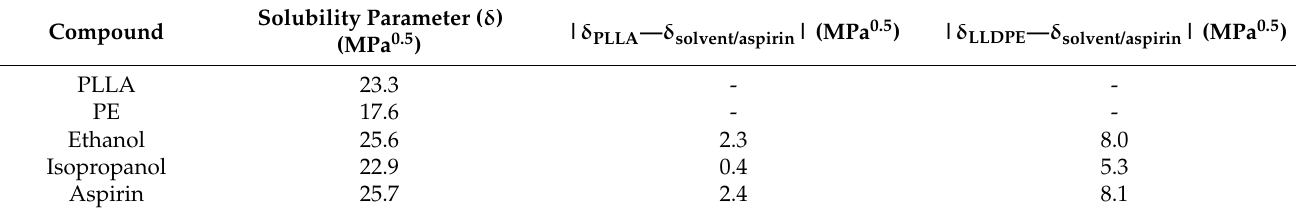
Table 6. Solubility parameters calculated using the Hoftyzer–Van Krevelen method [60].